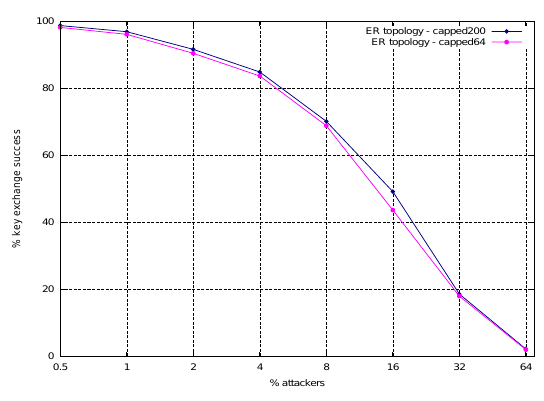
Figure 12. Influence of the maximum number of authorized hops.